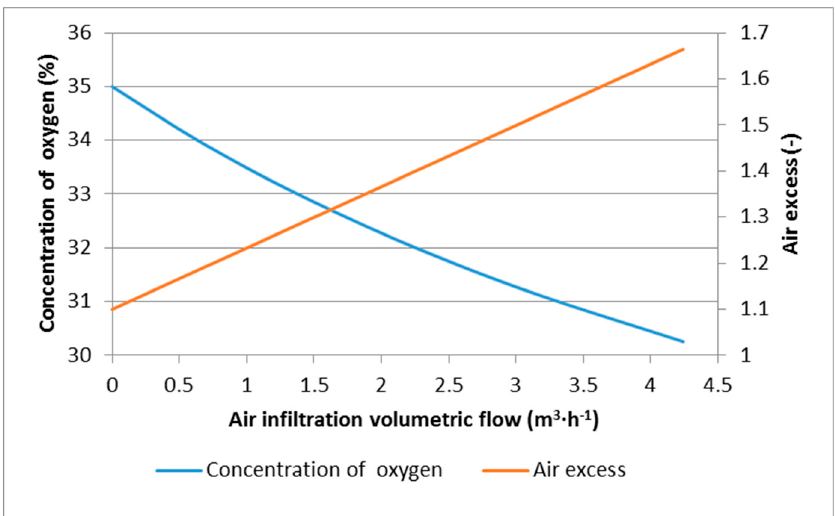
Figure 8. Dependence of oxygen concentration and combustion air excess on the amount of infiltrating air (mathematical modeling).